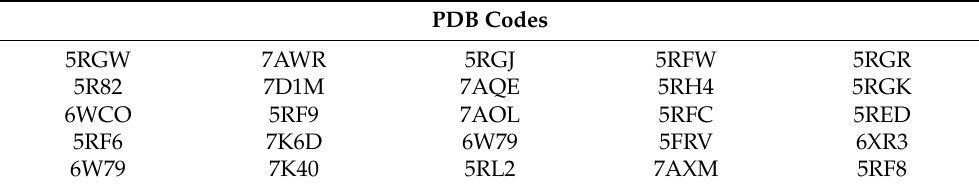
Table 8. PDB codes of Mpro with co-crystallized ligand having resolution < 1.5